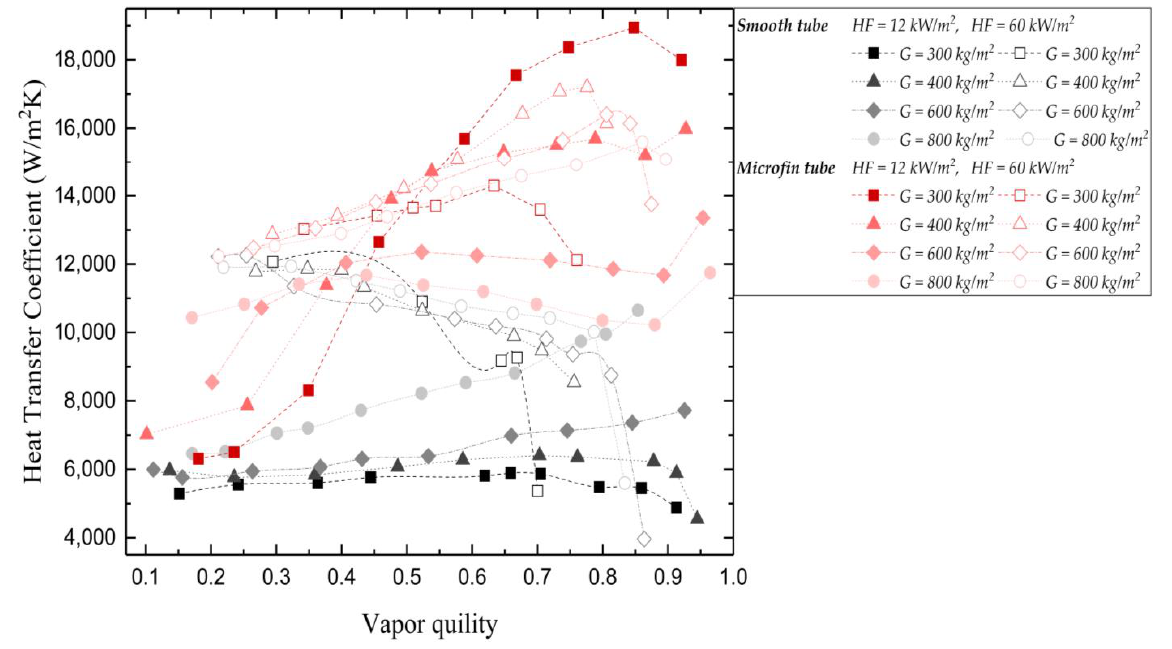
Figure 12. Effect of mass velocity on flow boiling HTCs at two heat fluxes (i.e., 12 and 60 kW/m 2 ) [73].